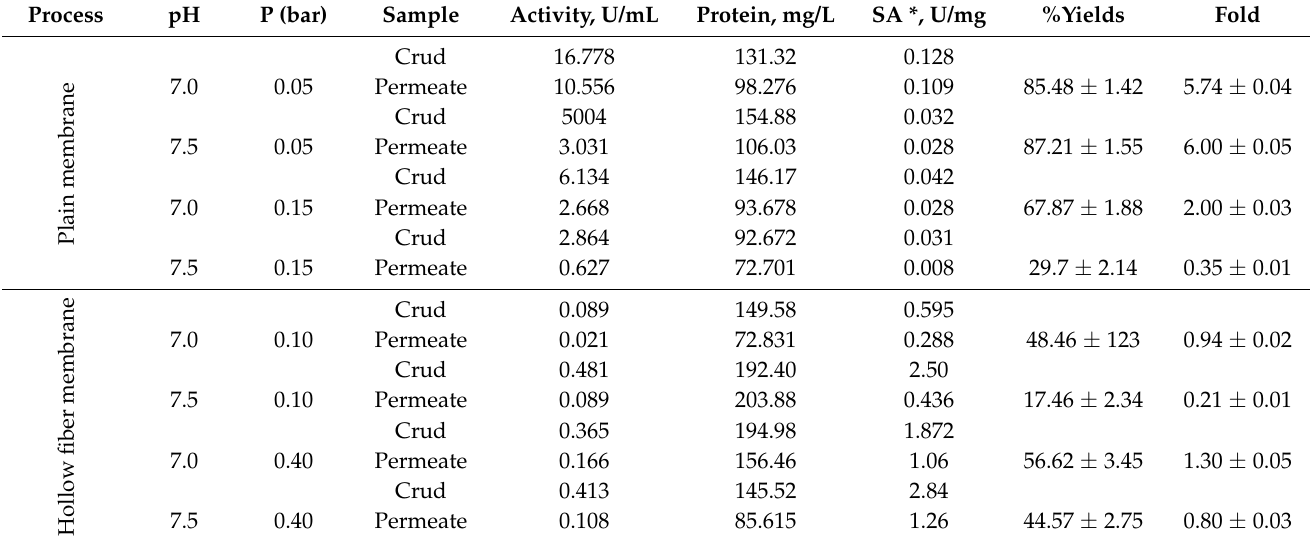
Table 3. Bromelain purification from A. comosus by polymeric plain and hollow fiber membrane, at 25 ± 2 ◦